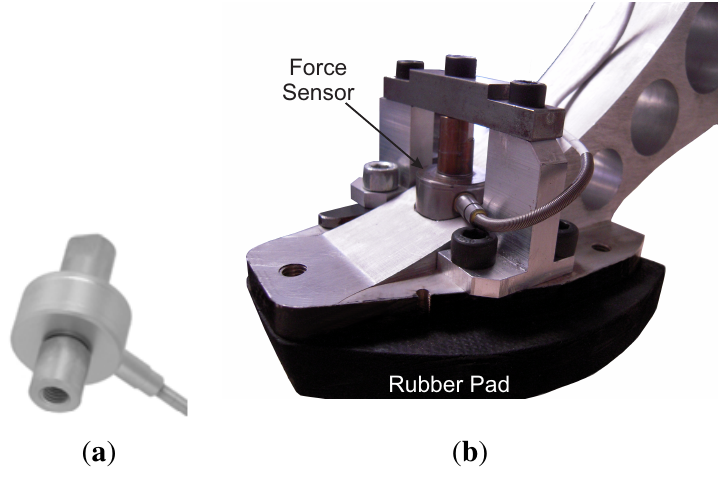
Figure 16. ( a ) Honeywell precision miniature load cell; ( b ) Sensor mounted on the hoof of the HADE leg.